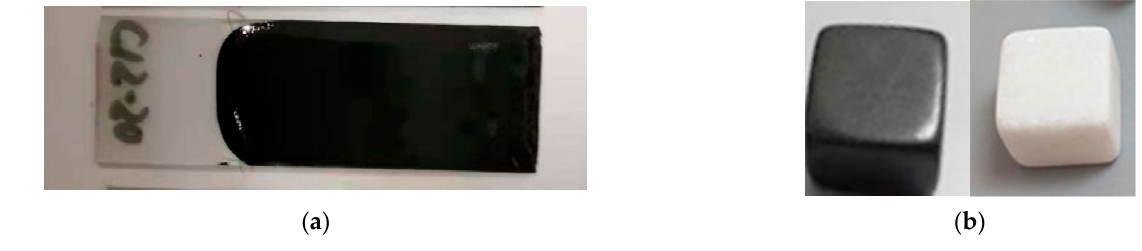
Figure 2. Contact angle measurement sample: ( a ) Crumb rubber sample, ( b ) Basalt and limestone blocks.